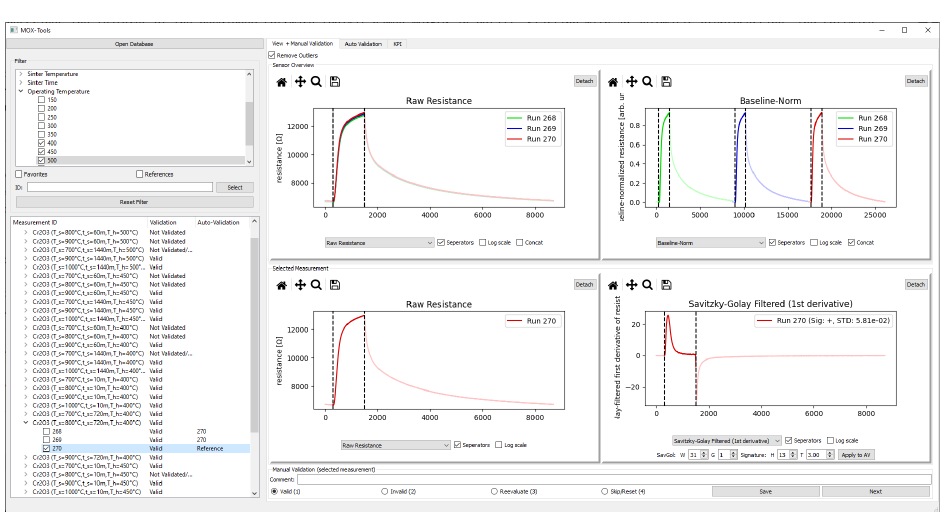
Figure 3. The software showing the View + Manual Validation